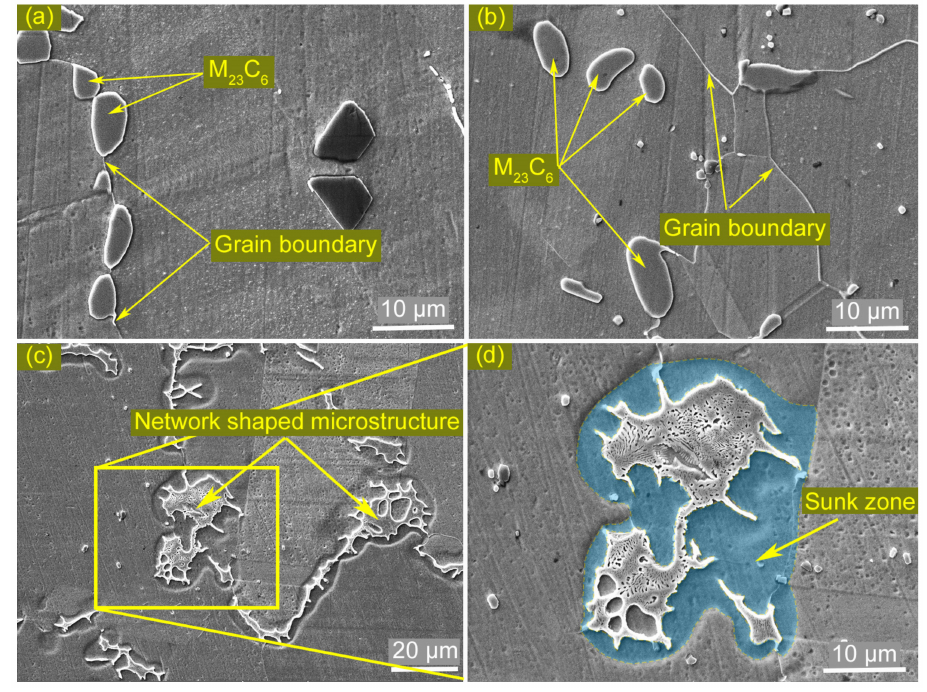
Figure 5. Microstructures observed by SEM after thermal simulation with varied peak temperatures ( a ) T p1 = 1200 ◦ C, t p1 = 0.5 s, ( b ) T p1 = 1250 ◦ C, t p1 = 0.5 s, ( c ) and ( d ) T p1 = 1300 ◦ C. t p1 = 0.5